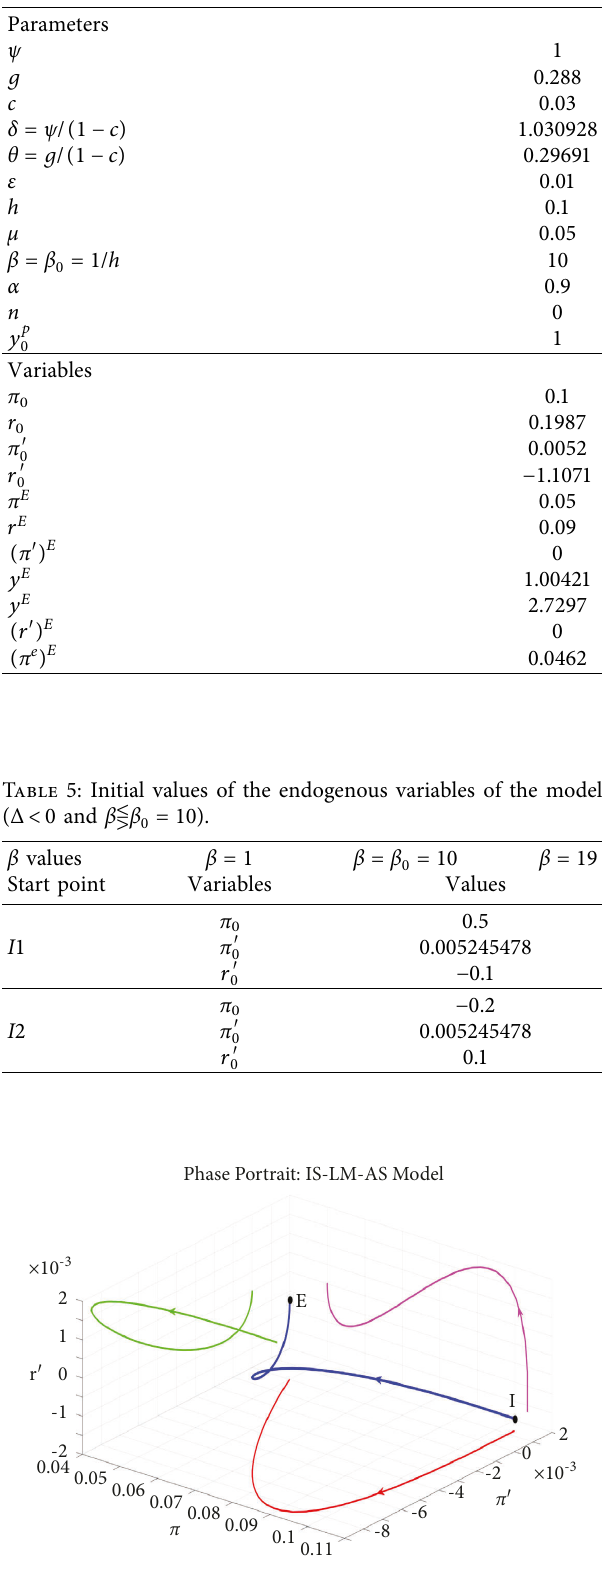
Figure 4: Three-dimensional phase portrait.